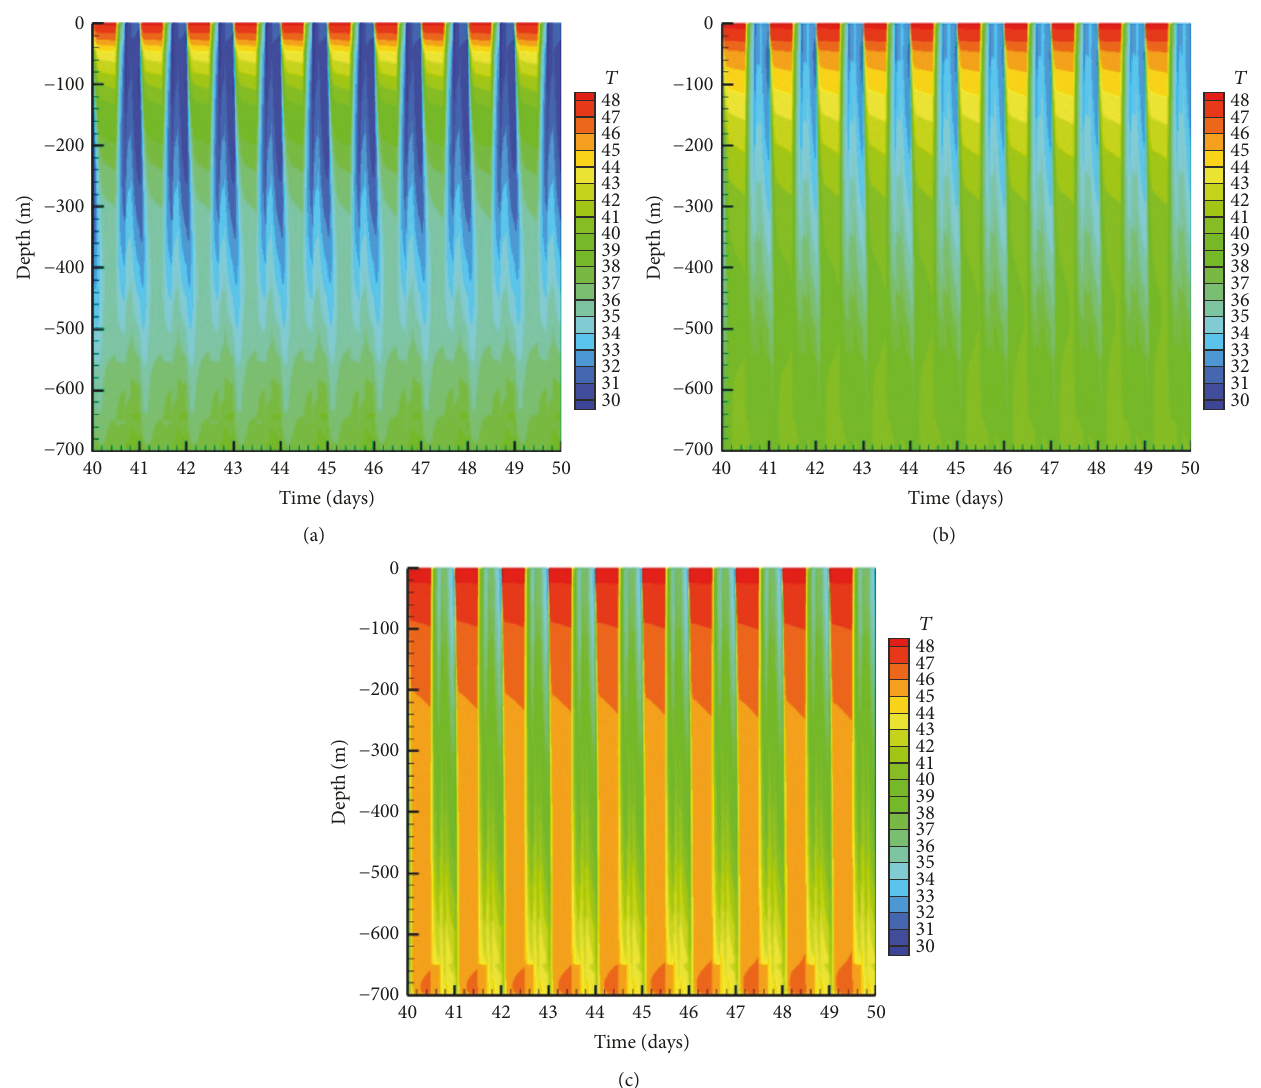
Figure 10: Temperature profiles along the wellbore among the three energy storage scales of the CAESA system during the 40–50 cycles. (a) 3.9 MW (injection 3 kg/s, production 12 kg/s); (b) 6.6 MW (injection 5 kg/s, production 20kg/s); (c) 13.1MW (injection 10kg/s, production 40 kg/s).